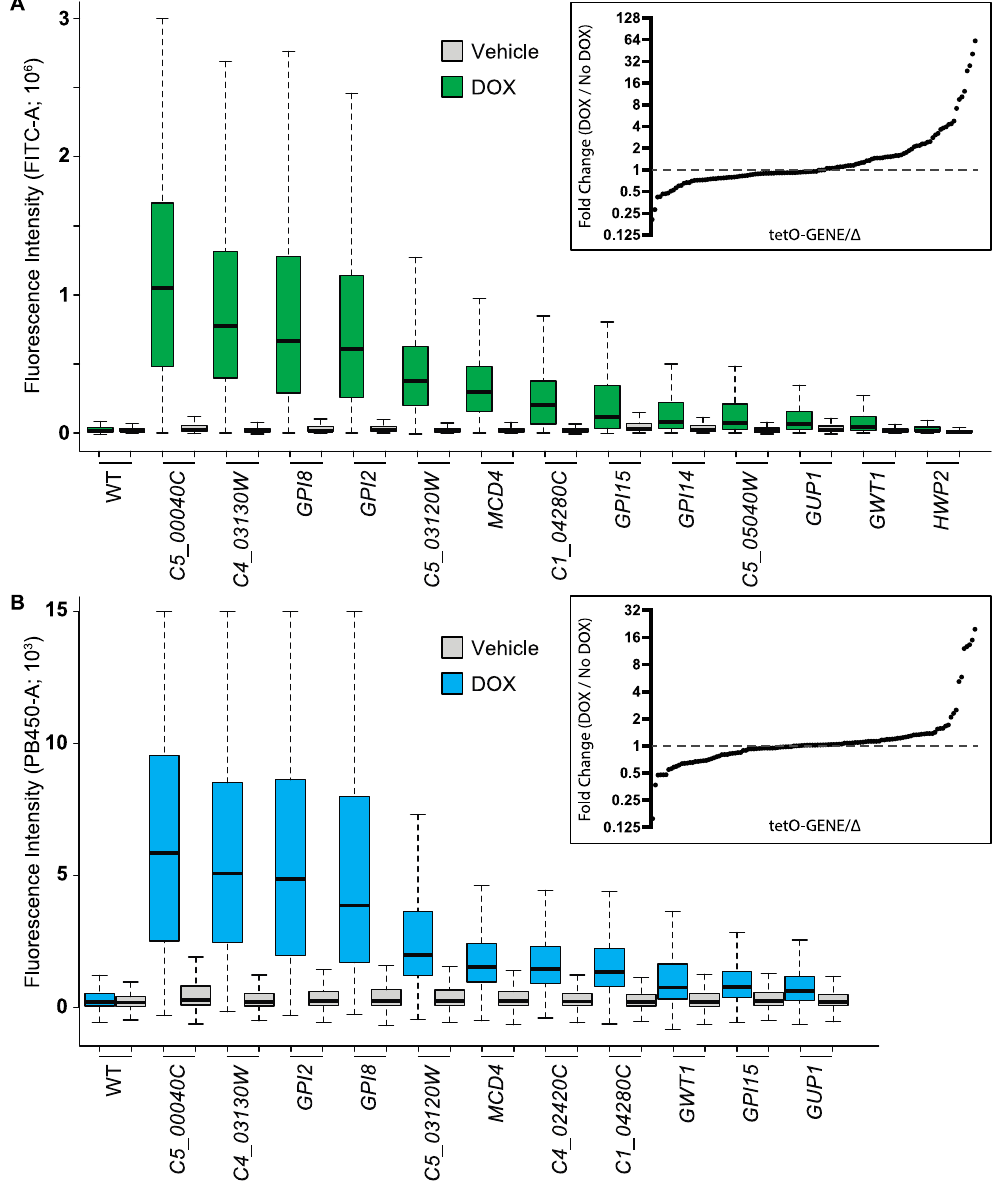
Figure 5. Transcriptional repression of GPI-anchor biosynthesis genes exposes (1 → 3)- β - D -glucan at the fungal cell surface and increases chitin levels. Conditional expression strains were grown in the presence or absence of DOX to repress target gene expression. Glucan and CFW staining and flow cytometry were performed as in Figure 4. ( A ) Glucan Staining. Median fluorescence intensity (FITC-A) is plotted for each repressible mutant in the library showing > two-fold change in median fluorescence intensity in screening and validation experiments upon repression of the indicated gene in shaking cultures. Values depicted represent a single determination (~30,000 events/sample). Inset: Screening data. Ratio of median fluorescence intensity of DOX-treated to untreated samples for all strains in the collection grown in static cultures. Values depicted repre- sent a single determination (>1000–10,000 events/sample). ( B ) CFW Staining. Median fluorescence intensity (PB450-A) is plotted for each repressible mutant in the library showing > two-fold change in median fluorescence intensity in two experiments upon repression of the indicated gene in shaking cultures. Values depicted represent a single determination (~30,000 events/sample). Inset: Screening data. Ratio of median fluorescence intensity of DOX-treated to untreated samples for all strains in the collection grown in static culture. Values depicted represent a single determination (>1000–10,000 events/sample).